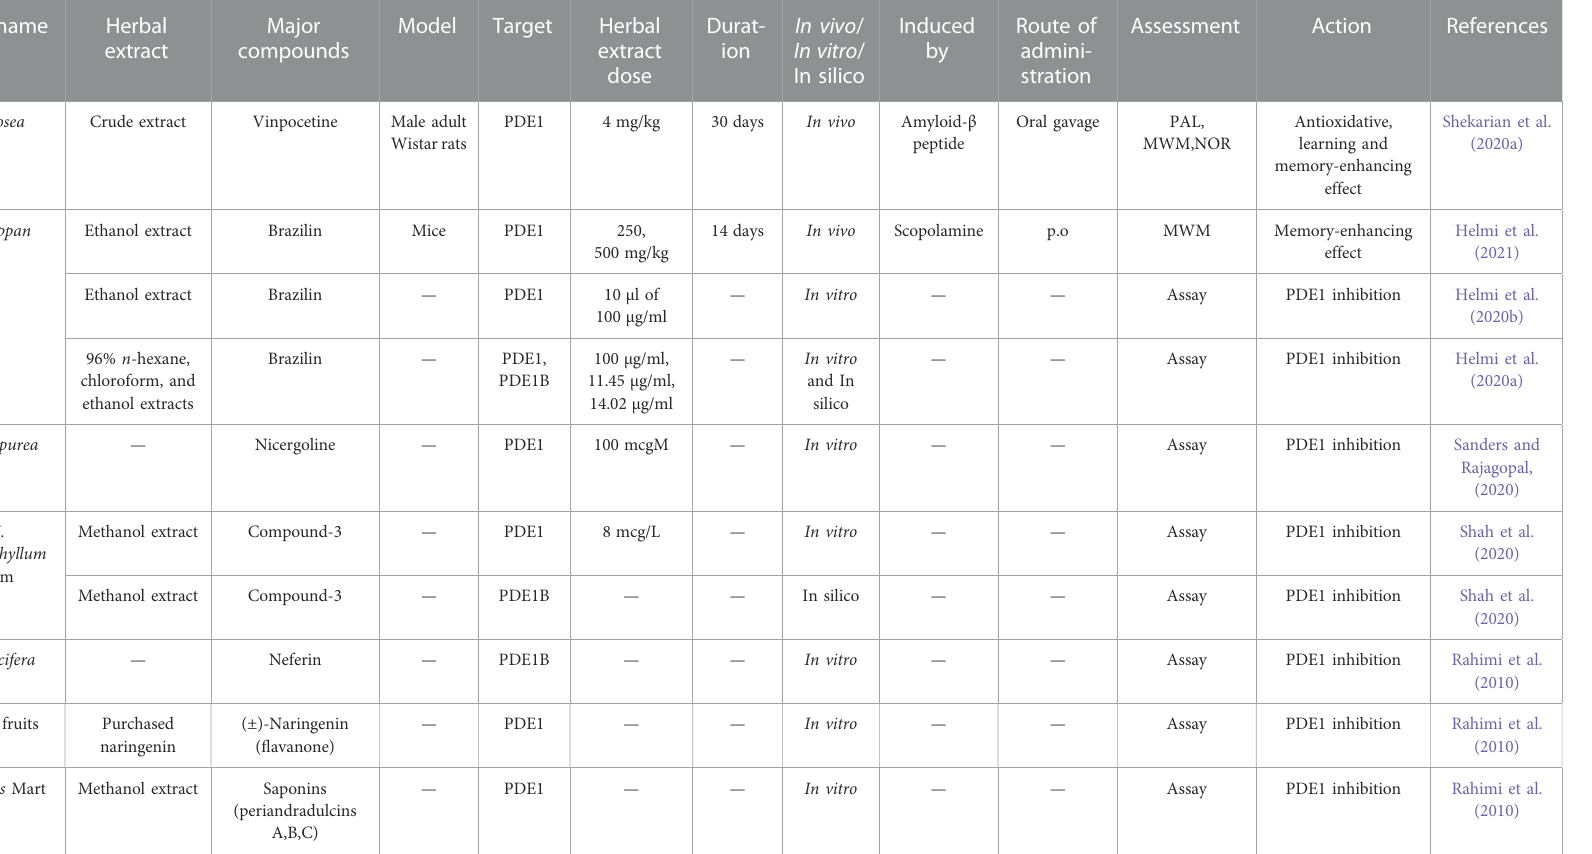
TABLE 2 Detail of previously studied plant extracts as inhibitors of PDE1 and its isoforms.